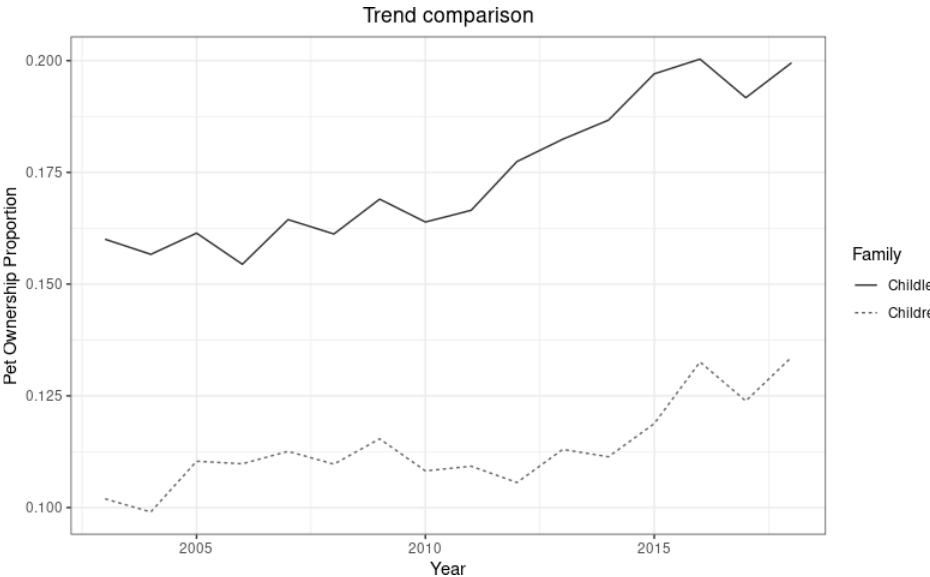
Figure 1. Trends of pet ownership in households with and without children. The results are plotted in three panels. The first panel shows the data and a counter- factual prediction for the post-treatment period. The second panel shows the difference